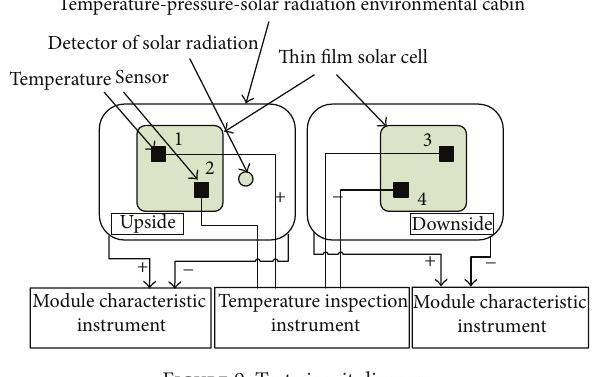
Figure 12: Thermal conductivity of Nomex honeycomb.